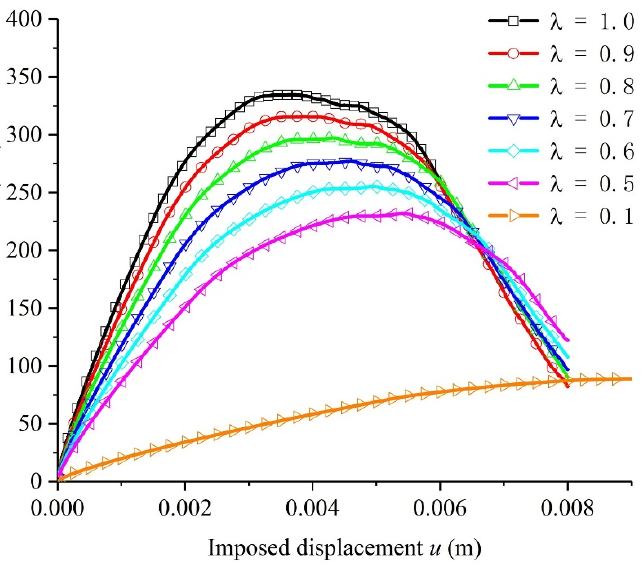
Figure 8. Curves of the reaction force versus imposed displacement for different ratios of the orthotropic Young’s moduli.